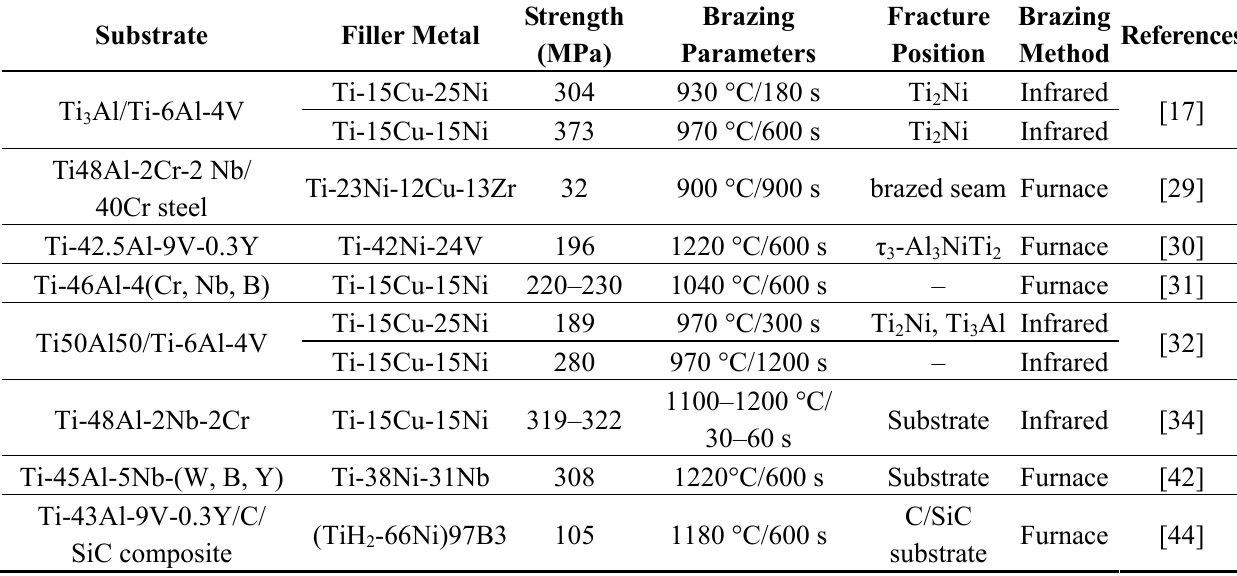
Table 2. The mechanical properties of titanium aluminides brazed joint using Ti-based filler